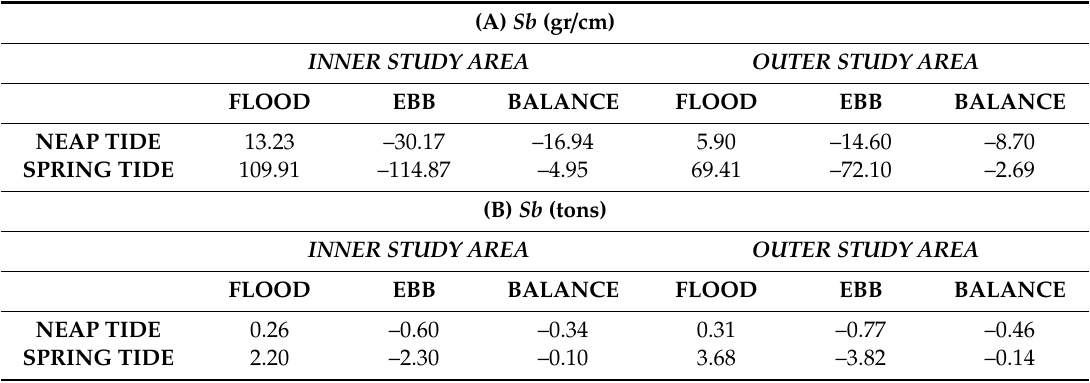
Table 2. Material caught by traps and considered real bedload transport ( Sb ) for the complete tidal semicycles. ( a ) Values expressed in g / cm obtained directly from traps (sediment weight divided between the 30 cm of the trap section). ( b ) Values obtained for the complete flow section (expressed in tons).